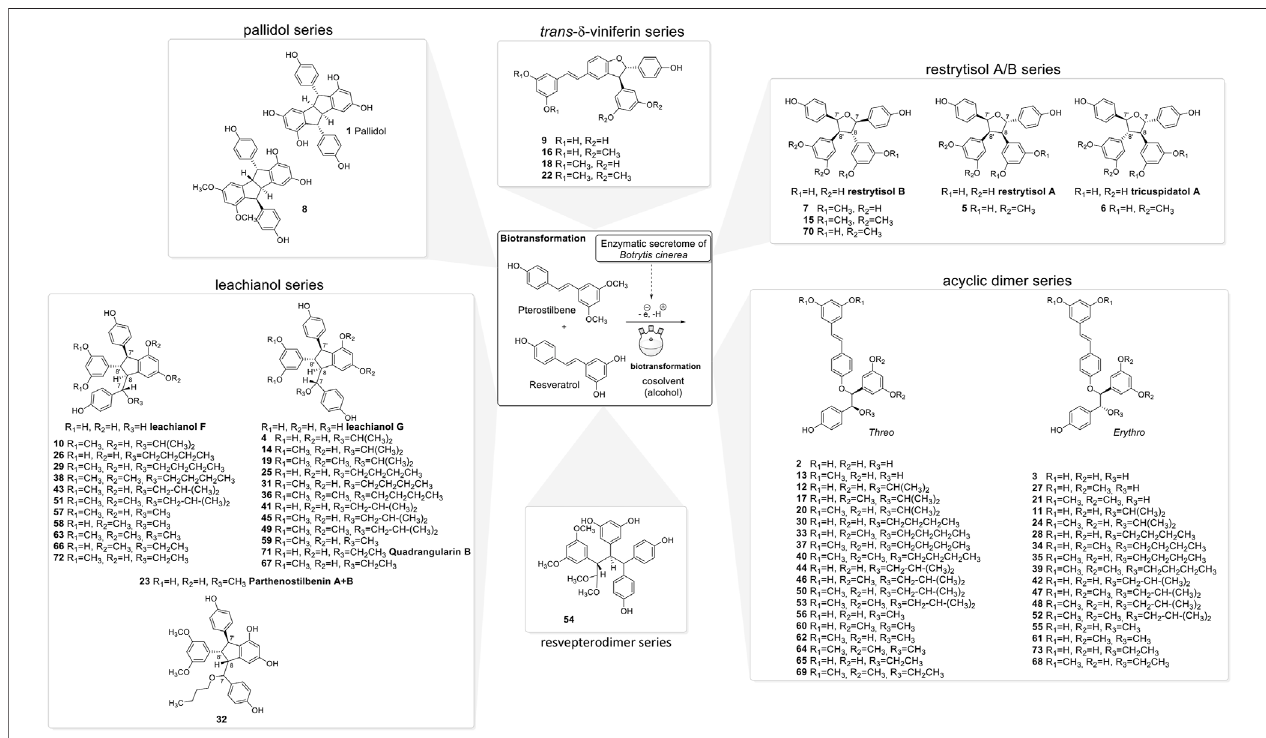
FIGURE 3 | Compounds isolated from the biotransformation reactions of the mixture of resveratrol and pterostilbene with the secretome of Botrytis cinerea in the presence of 50% of different organic solvents ( i -PrOH, n -BuOH, i -BuOH, EtOH, or MeOH).